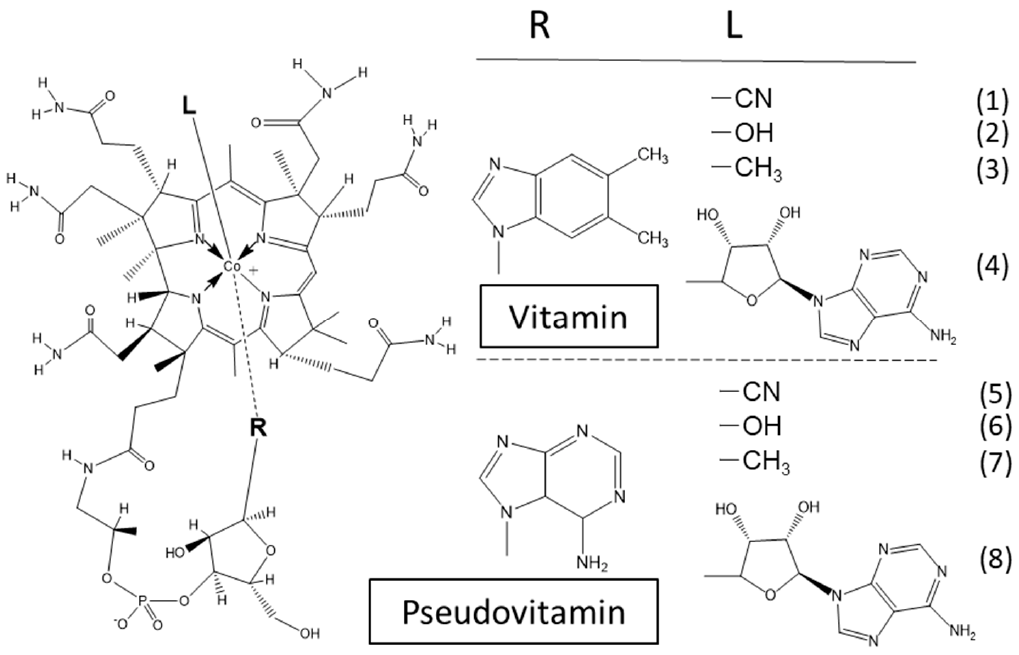
Figure 1. Structural formula of vitamin B 12 and partial structures of vitamin B 12 -related compounds. ( 1 ) Cyanocobalamin (vitamin B 12 , Cbl, or CN-Cbl), ( 2 ) hydroxocobalamin (OH-Cbl), ( 3 ) methylcobalamin (MeCbl), ( 4 ) adenosylcobalamin (AdoCbl), ( 5 ) pseudovitamin B 12 [(Ade)Cba], ( 6 )